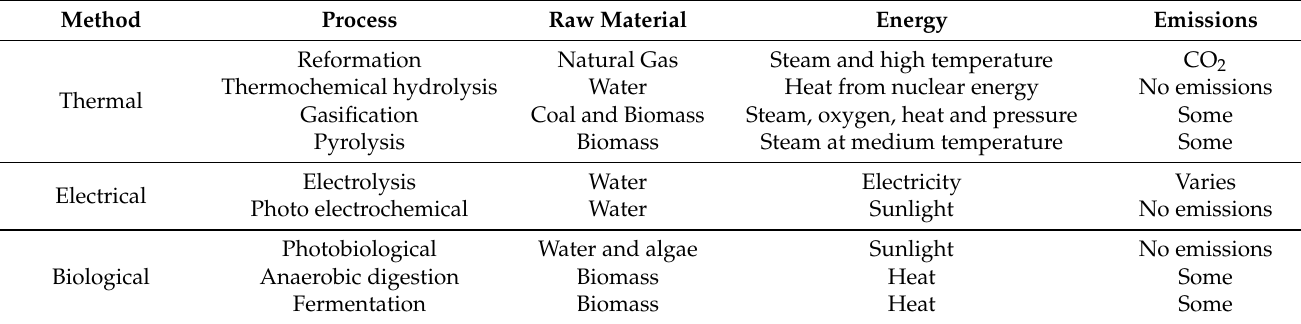
Table 1. Hydrogen production